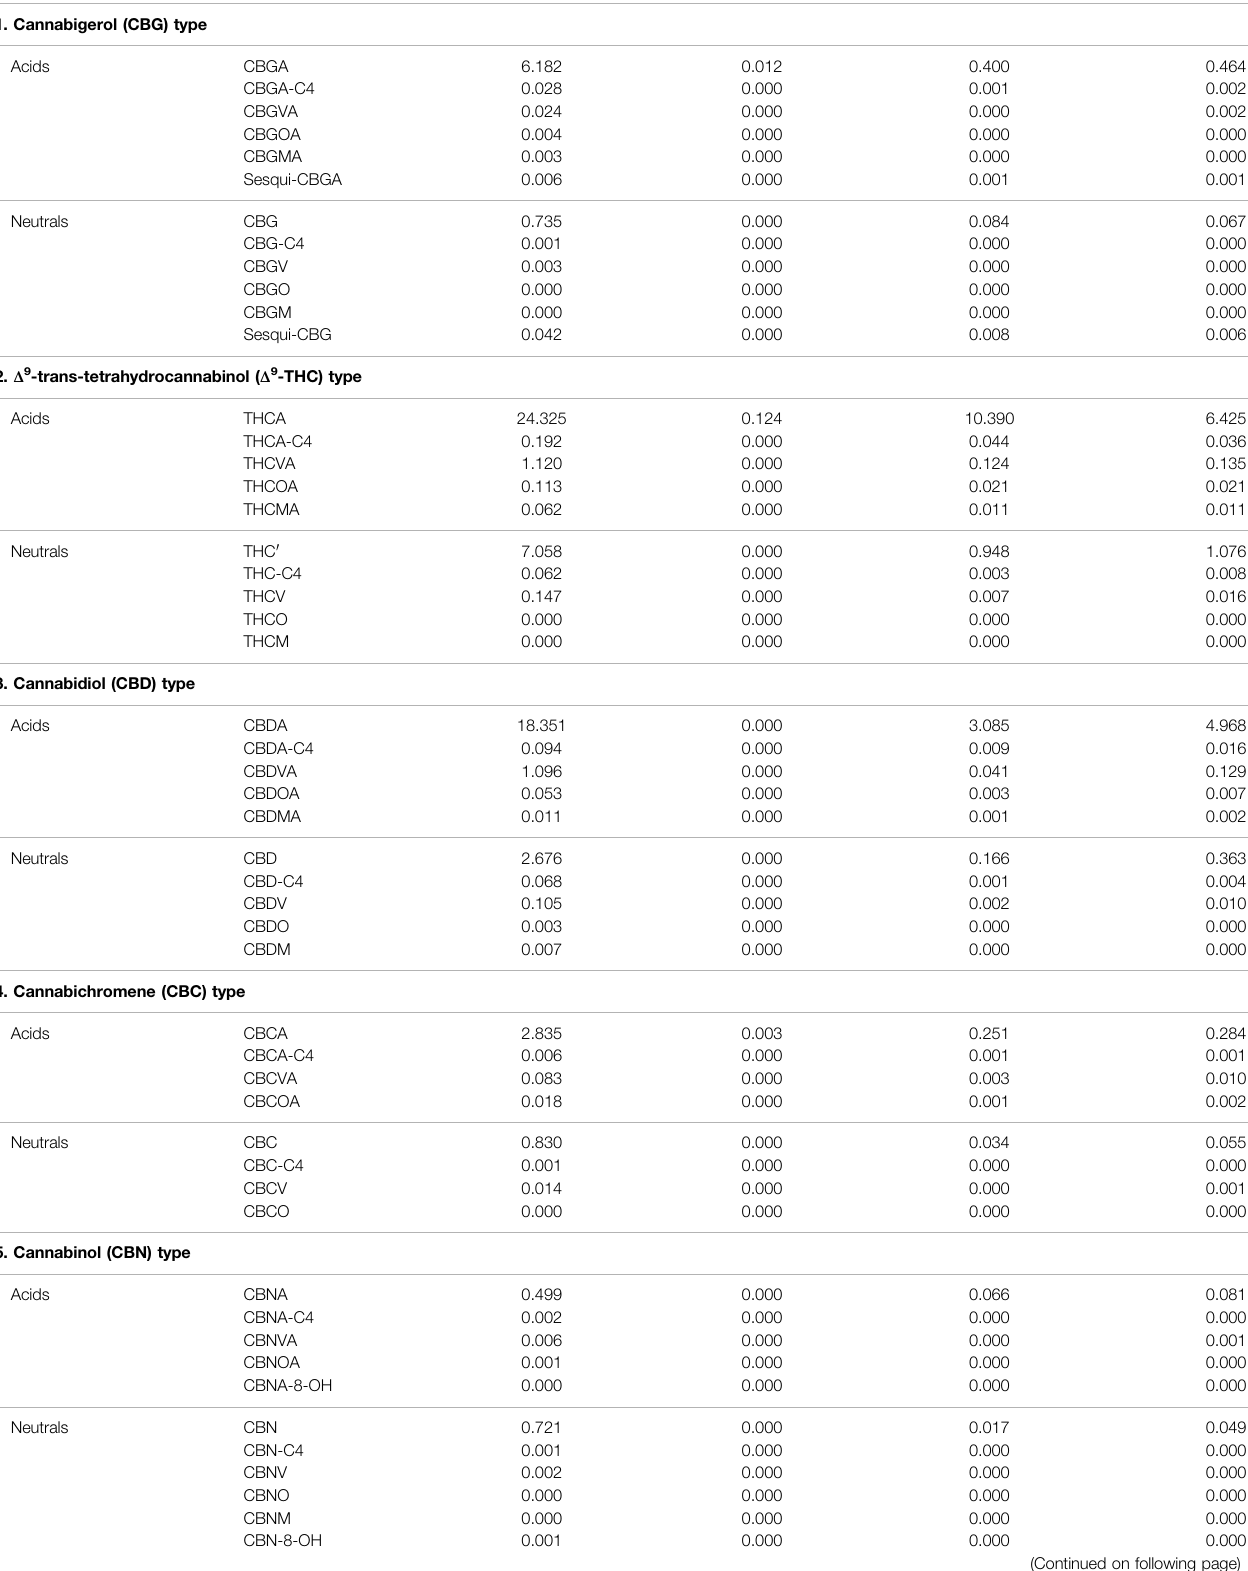
TABLE 1 | Variability of phytocannabinoids in 320 different cultivars. Presented as concentration values